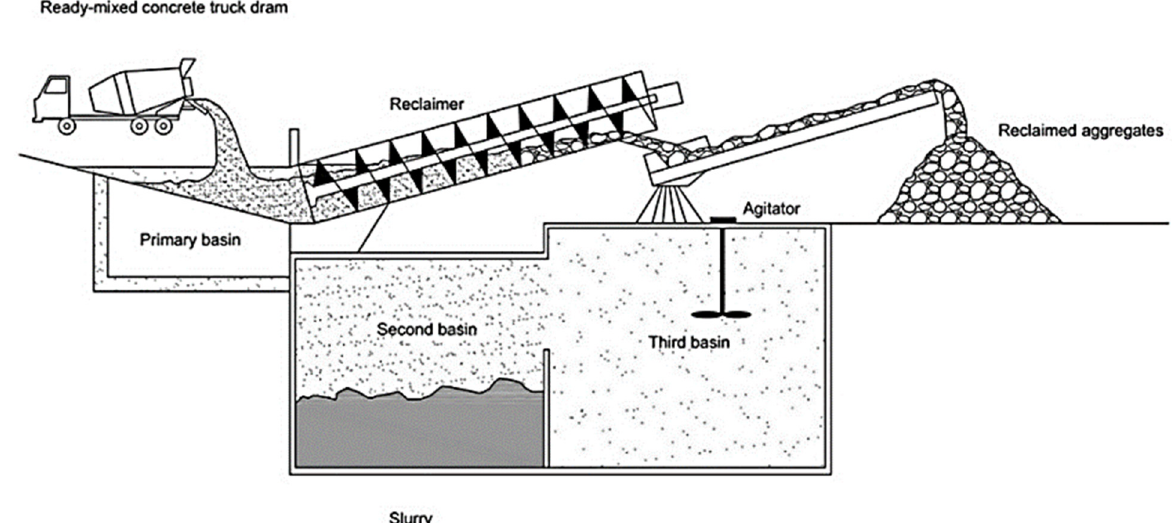
Figure 3. Illustration of CSW and reclaimed concrete aggregates [165].